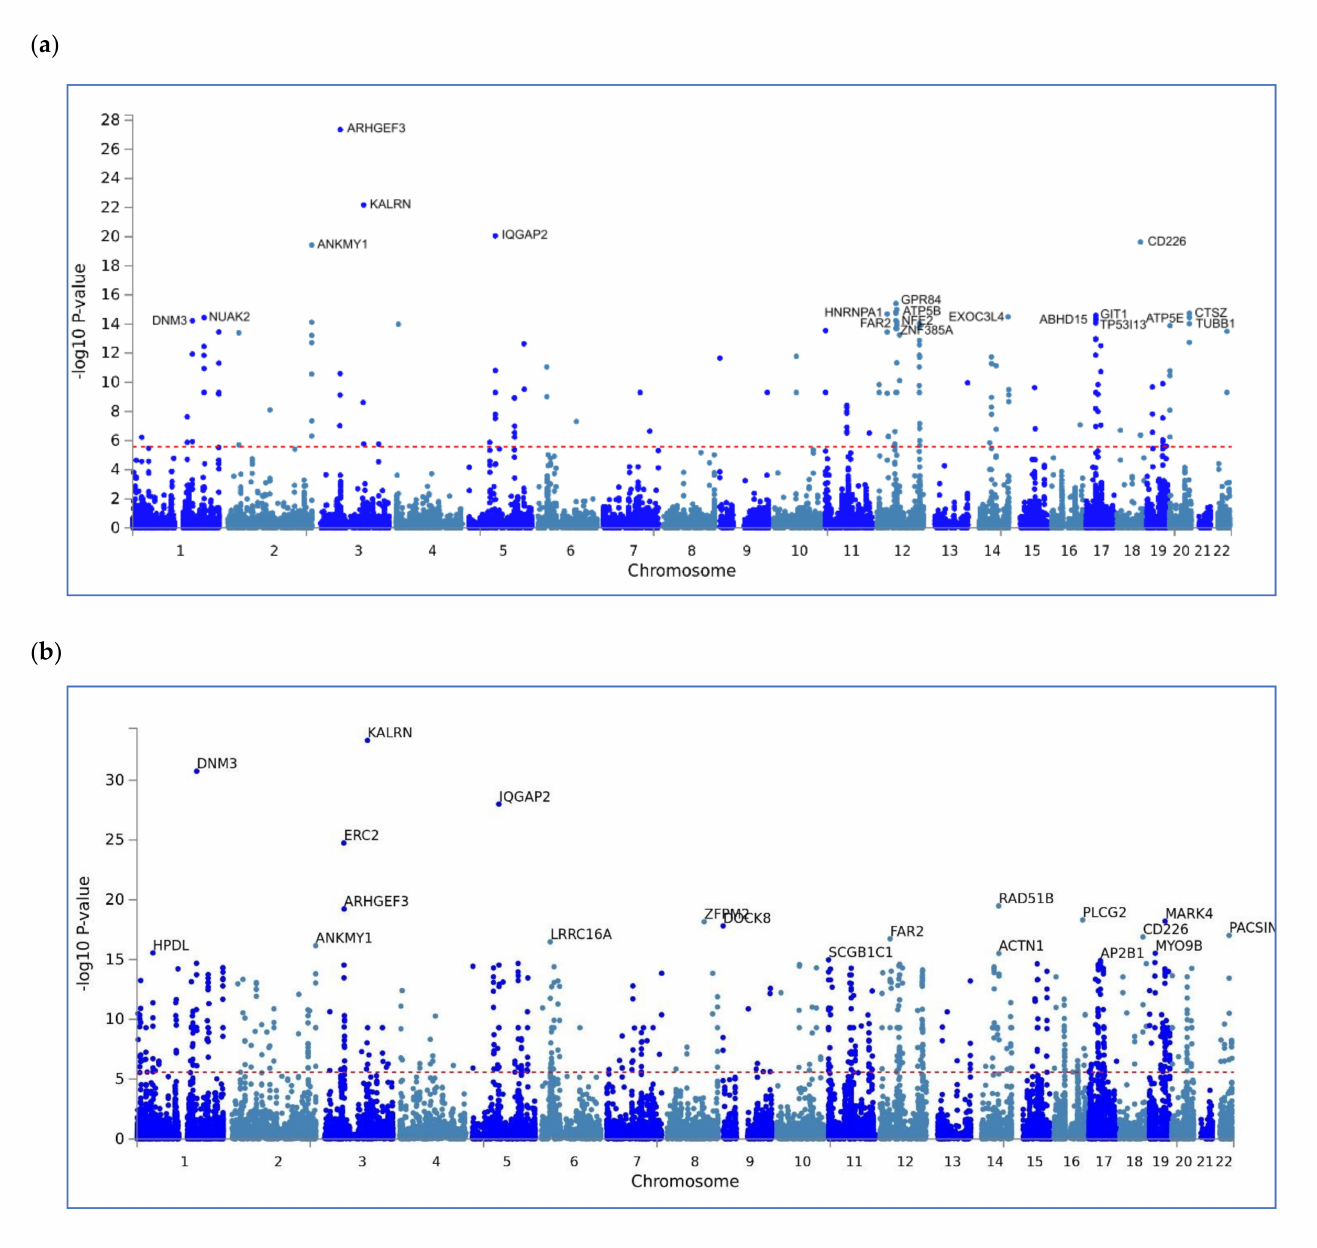
Figure 2. Manhattan Plot of gene-based enrichments of multitrait single-variant associations with ( a ) PD-AAO and ( b )